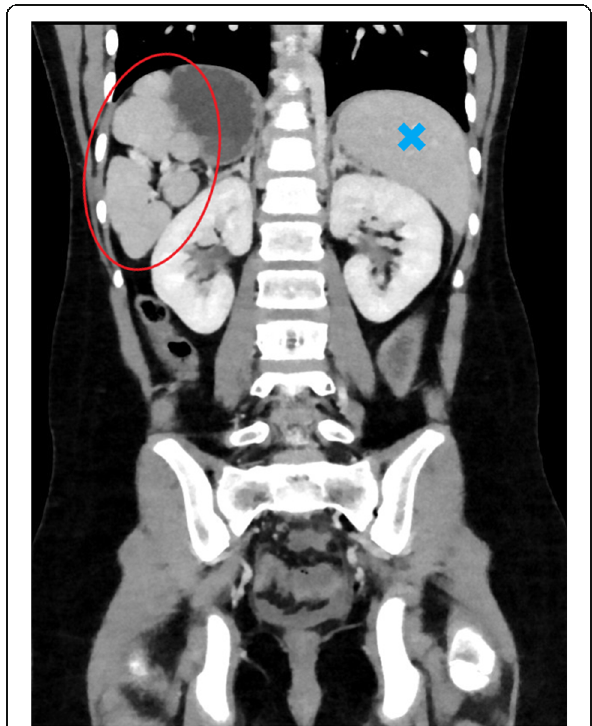
Fig. 1 CT scan of the abdomen with IV contrast demonstrating the polysplenia and left isomerism. Red circle: Polysplenia, located in the right upper abdominal quadrant. Blue cross: liver, located in the left